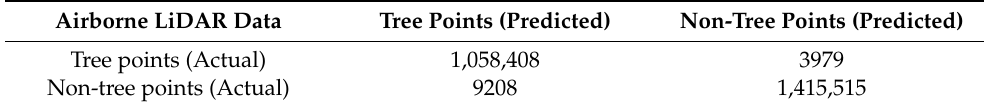
Figure 8. The edges of the building that were mistakenly extracted as trees are shown as red points.